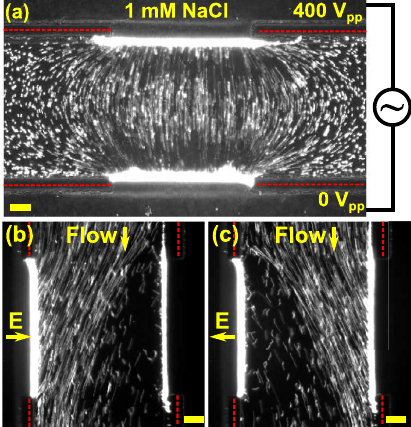
FIG. 6. (a) An ac potential applied between reservoir channel inlets drives an electric field that only crosses the sample channel through the HMMs. Fluorescent colloids in the sample channel oscillate electrophoretically, tracing local electric-field lines much like iron filings align with magnetic fields. Panels (b-c) and Video 6: Continuous-flow electrophoretic separations of negatively charged colloids by applying a dc electric field E transverse to the flow. Scale bars: 20 (cid:1) m